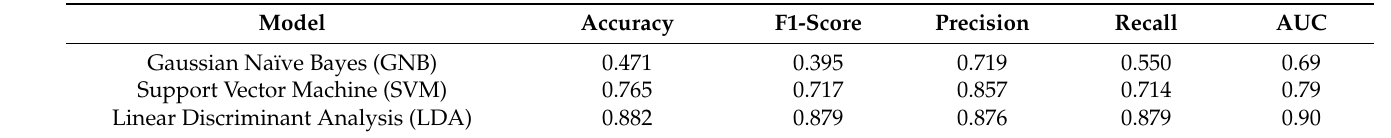
Table 6. Classification report for each model of the pipeline. The main metrics are represented: accuracy, f1-score, precision, recall and area under the curve